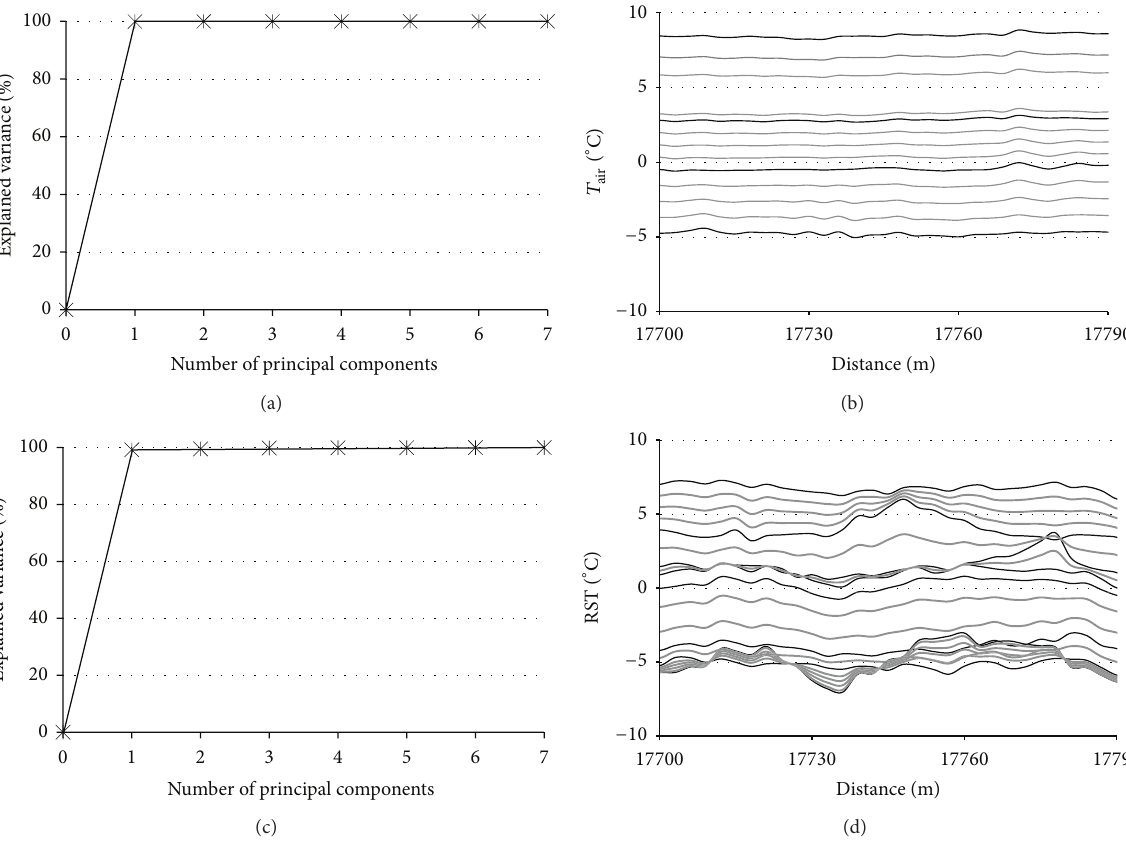
Figure 4: Results (explained variance (a, c) and interpolation (b, d)) of PCA applied to 𝑇 air and RST profiles of the urban stretch.